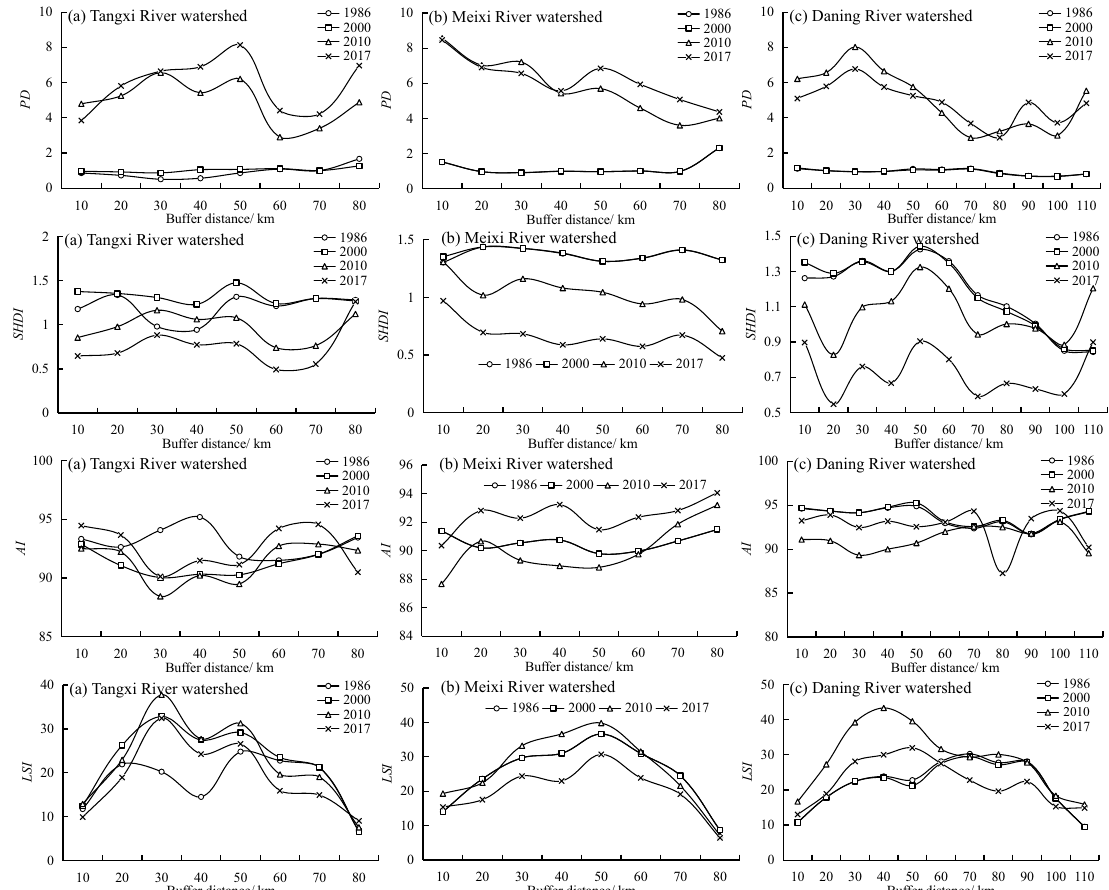
Figure 8. Changes in landscape metrics along with the buffer distance of the watershed from 1986 to